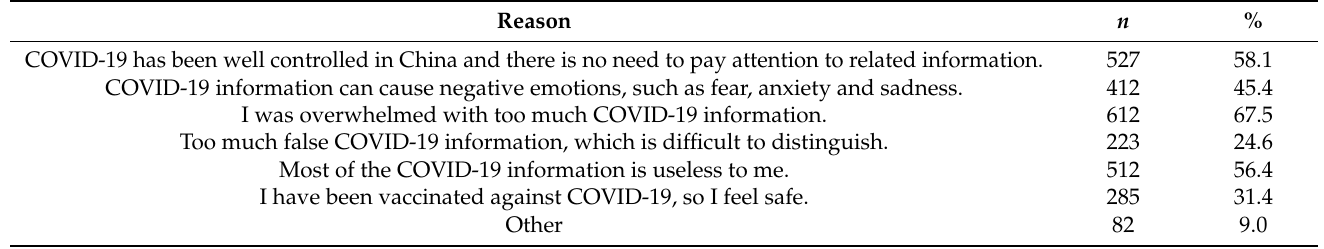
Table 2. Reasons for COVID-19 information avoidance among elderly people in Wuhan, China ( n = 907).